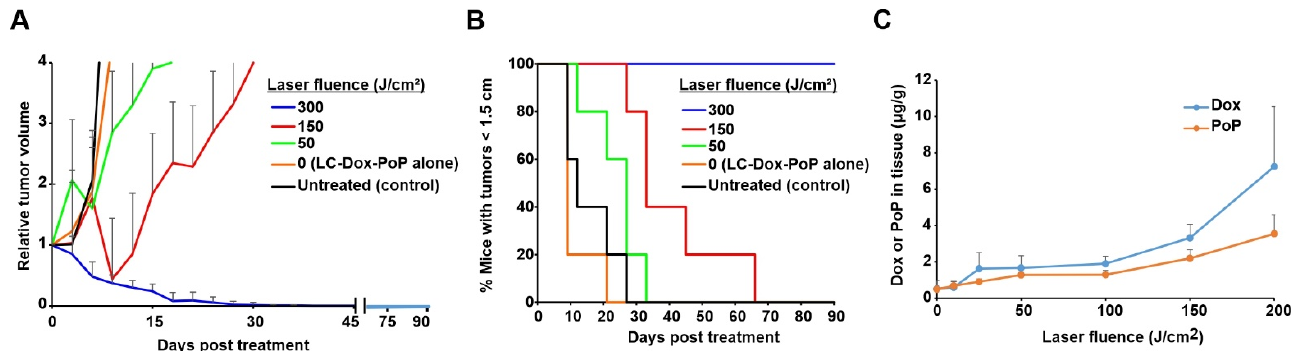
Figure 1. Chemophototherapy enhances drug delivery even at suboptimal light doses. Mice bearing MIA PaCa-2 tumors were intravenously injected with 3 mg/kg LC-Dox-PoP liposomes and treated with a 665 nm laser at a 150 mW/cm 2 fluence rate, at varying laser fluences with a 1 h DLI. ( A ) Relative tumor growth. ( B ) Percentage of mice with tumors less than 1.5 cm. Data show mean ± std. dev. for n = 6 mice per group. ( C ) The Dox and PoP concentration in LC-Dox-PoP liposomes in MIA PaCa-2 tumor xenografts laser-treated with indicated fluences (at a fluence rate of 150 mW/cm 2 ) with a 1 h DLI. Dox and PoP in tumor were assessed 8 h afar drug administration. Data show mean ± std. dev. for n = 4 mice per group.